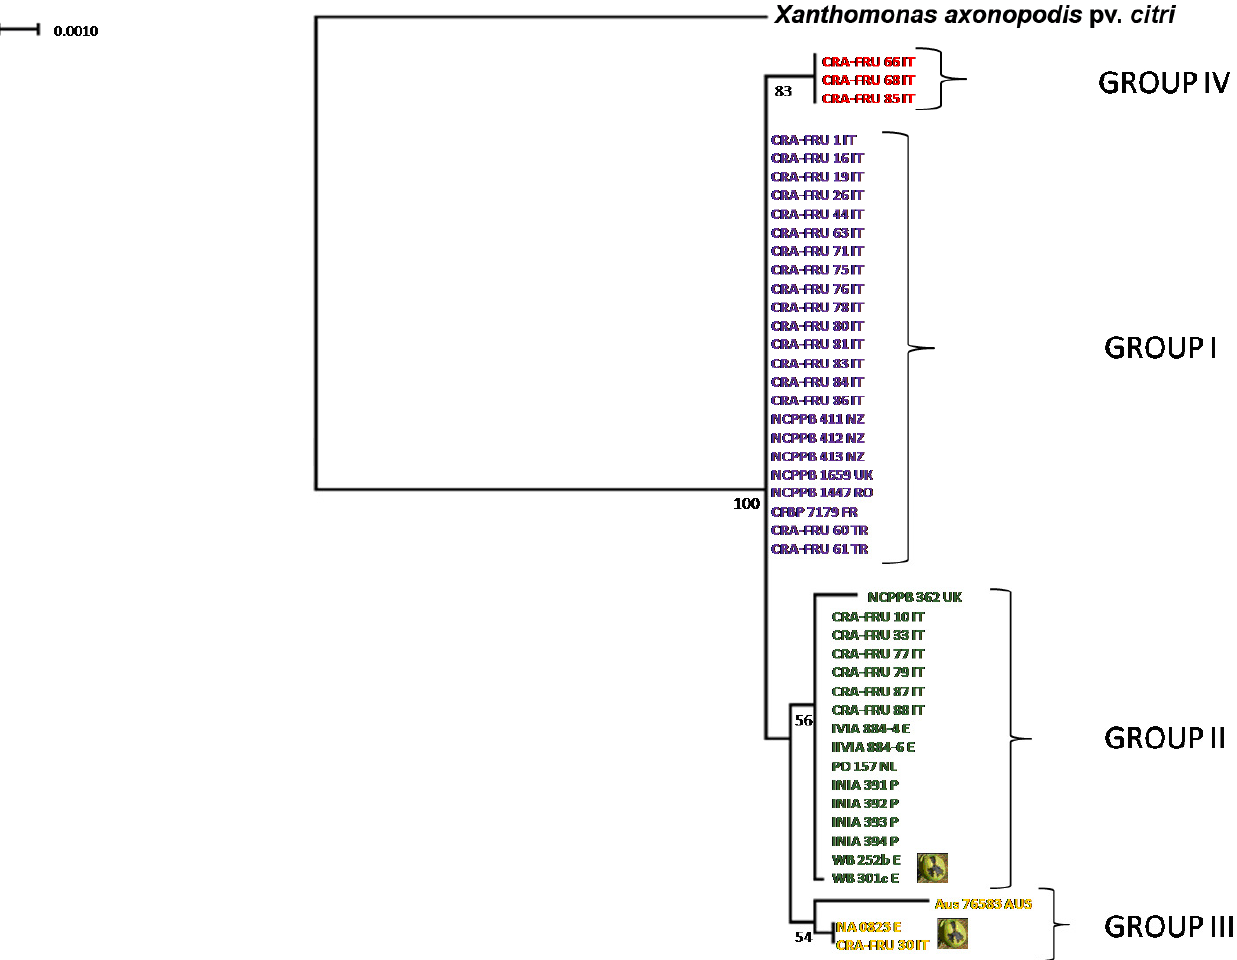
Figure 4. Dendrogram of relationships among X. a . pv. juglandis strains obtained by using the amino acid sequences of acnB , gapA , gyrB and rpoD. Bootstrap values are reported at the main nodes. The X. a . pv. juglandis strains isolated from apical necrosis of walnut fruits are pointed